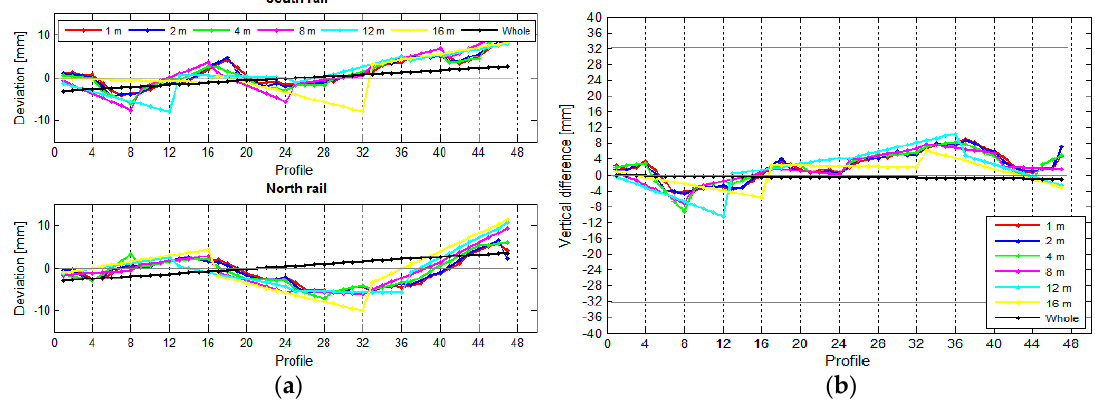
Figure 19. ( a ) The vertical variances and ( b ) the height differences in relation to the length of the segment.